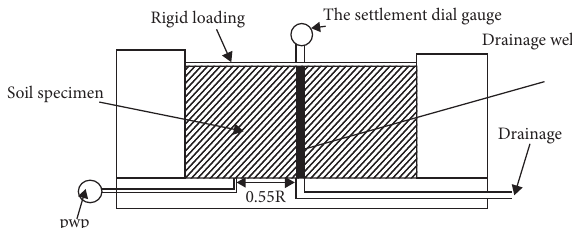
Figure 1: The Rowe consolidation cell for radially inward